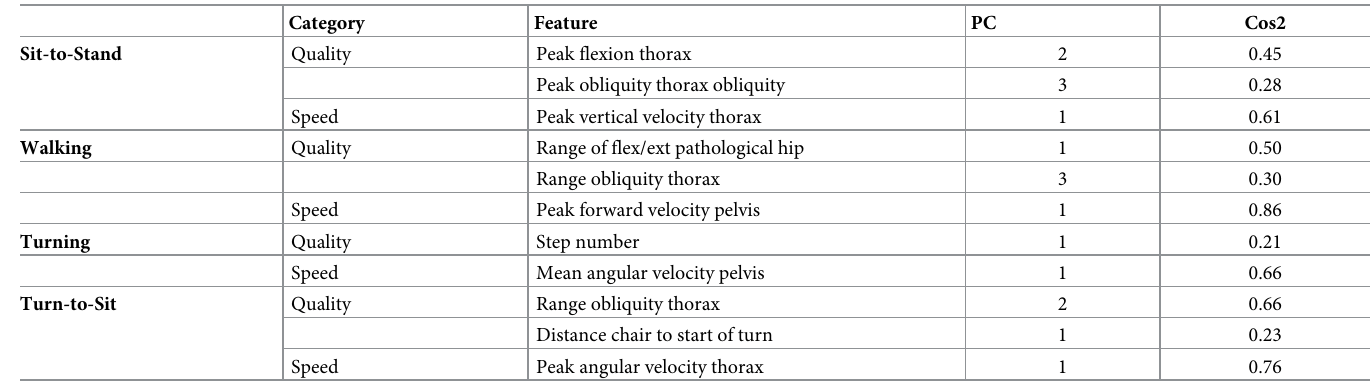
Table 3. Features selected using principal component